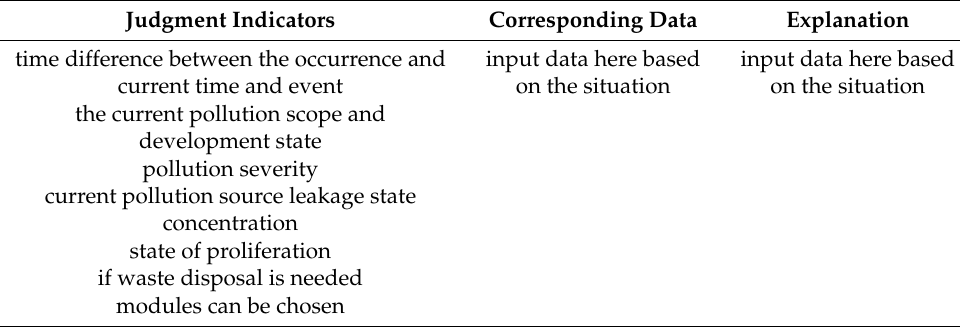
Table 2. Judgment assist index system for the start of each stage.